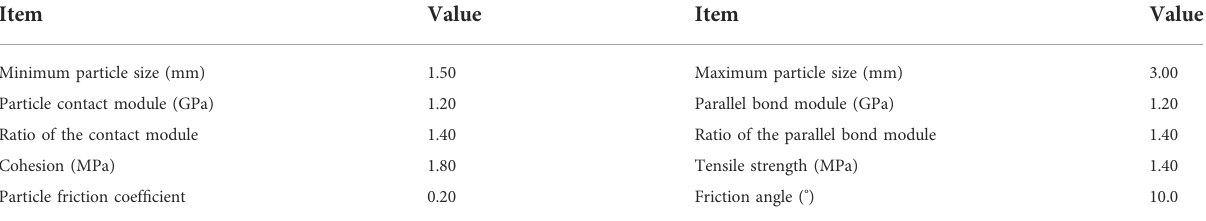
TABLE 4 Determined micro